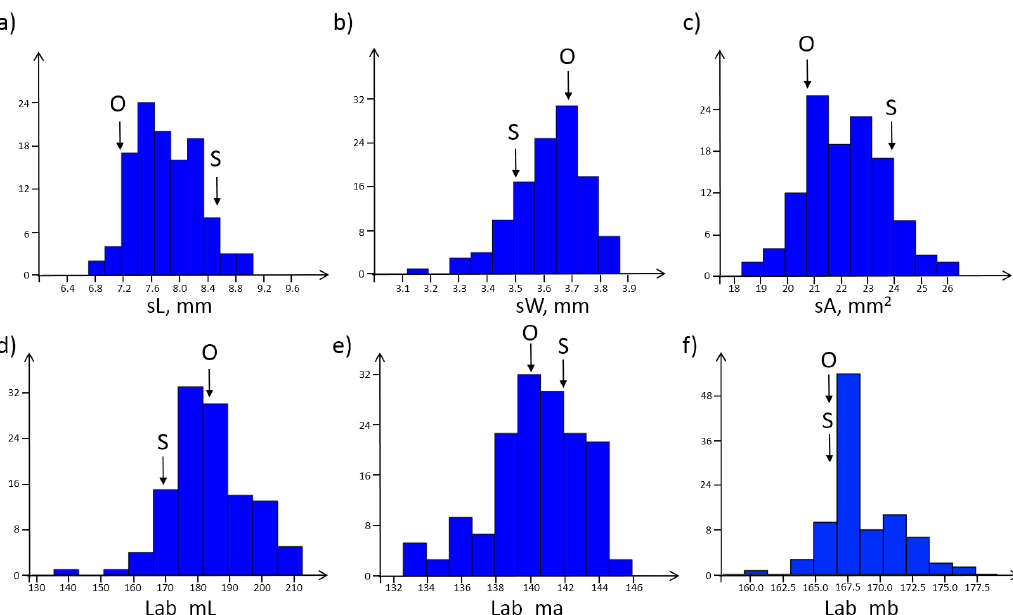
Figure 1. Distribution of six characteristics of seed size and color. The X -axis is the value of the characteristic, and the Y -axis is the frequency in the sample. ( a ) seed length, sL; ( b ) seed width, sW; ( c ) area of seed projection in the image, sA; ( d ) intensity of component L of Lab color space (lightness); ( e ) intensity of component a of Lab color space (redness); ( f ) intensity of component b of Lab color space (yellowness). The arrows show the characteristic values for the parental genotypes Opata (O) and Synthetic (S).